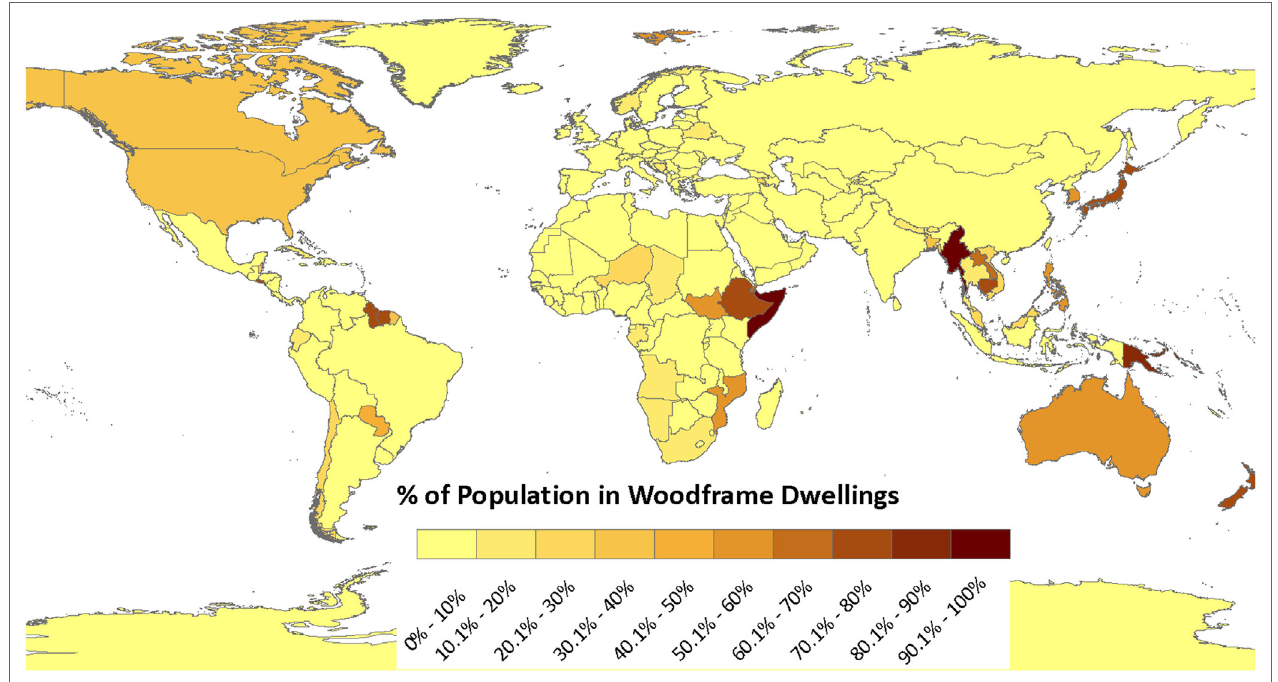
FigUre 3 | The percentage of population in wood-frame buildings globally for each country as created as part of Daniell et al. (2011c) .